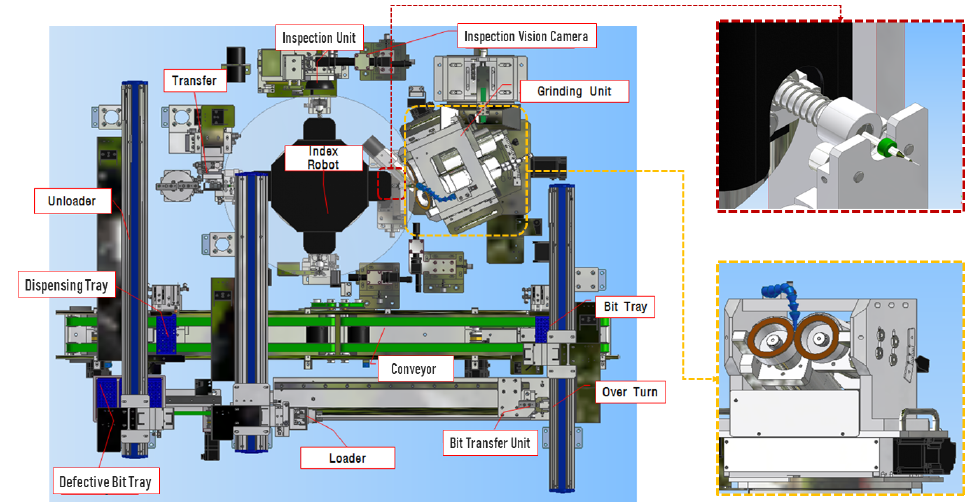
Figure 1. CAD plan view of the G50150 micro drill bit ARIS highlighting the collet and regrind- ing